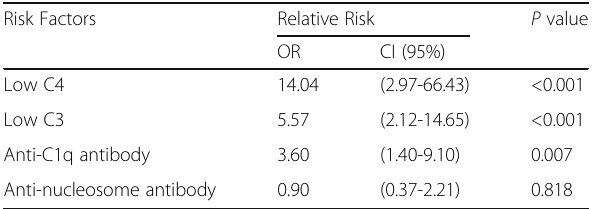
Table 7 Multivariate analysis of factors associated with lupus